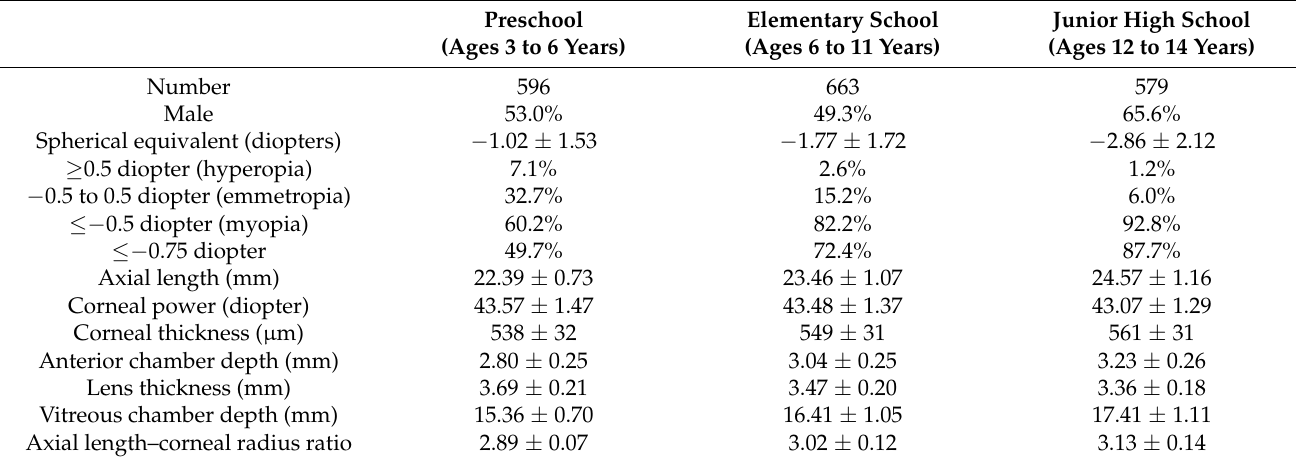
Table 1. Ocular characteristics based on school groups.